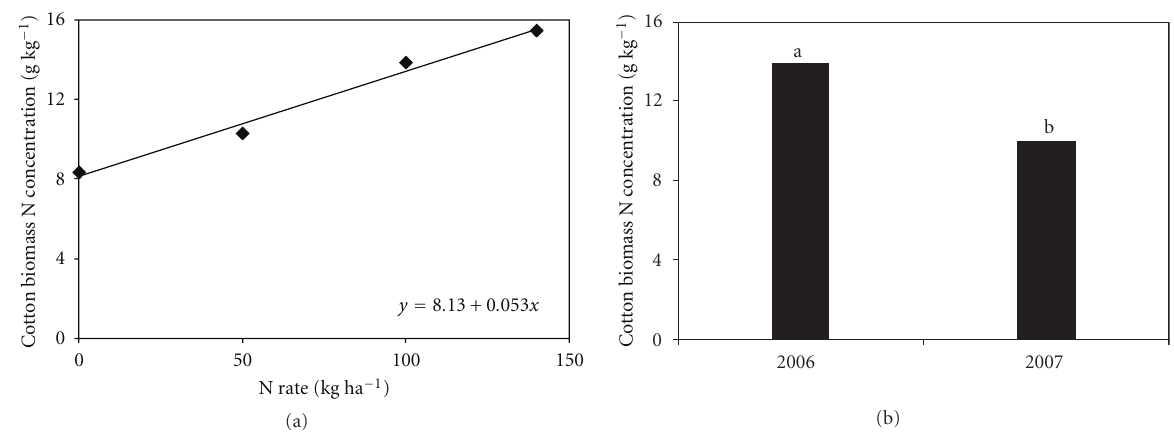
Figure 7: Cotton biomass N concentration between first square and cutout as a ff ected by (a) N rate (averaged across years and rye residue management) and (b) year (averaged across rye residue management and N rates). Columns followed by the same letter are not significantly di ff erent ( P ≤ 0 . 05).